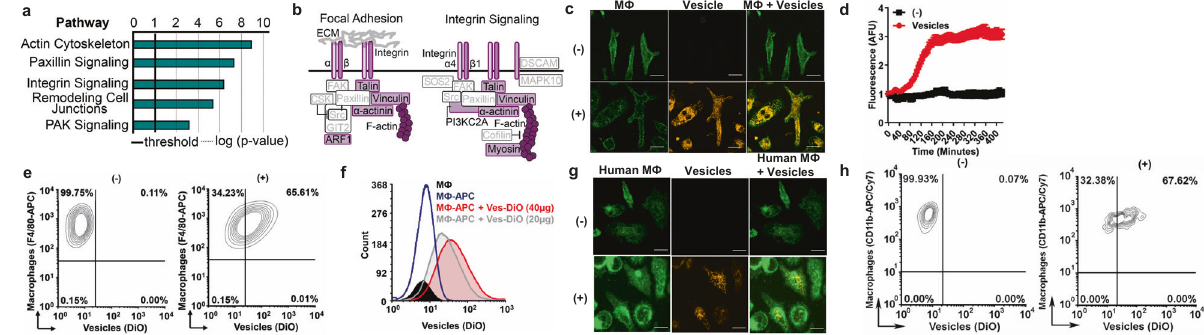
Fig. 2 Tick EVs bind to mammalian immune cells. a Overrepresentation of proteins involved in cell adhesion signaling networks in I. scapularis salivary gland EVs. The biological relationship between proteins was determined using the right-tailed Fisher ’ s exact test with Benjamini – Hochberg multiple-testing correction. p < 0.05; − log ( p value) >1.5. b Graphic representation of focal adhesion and integrin signaling proteins (purple) found in I. scapularis salivary gland EVs. Confocal images of c murine bone marrow-derived macrophages (BMDMs) (bar = 20 µ m) and g macrophages derived from human peripheral blood mononuclear cells (green) bound to I. scapularis EVs labeled with PKH26 (orange) (bar = 20 µ m), respectively. Cells were pre-treated with cytochalasin D (5 µ M). ( − ) No EVs; ( + ) EVs. Images are representative of two independent experiments. d Arbitrary fl uorescent units (AFU) of murine BMDMs bound to PKH26-labeled tick EVs (red). BMDMs incubated in the absence of EVs (black). Each time point represents the mean fl uorescence from seven different cells minus background and normalized to time 0. Graphs show one of two independent experiments. Flow cytometry with e murine BMDMs (F4/80 + -APC) and h human macrophages (CD11b + -APC/Cy7) bound to DiO-labeled tick EVs (40 µ g), respectively. No EVs ( − ); EVs ( + ). Figures are representative of three biological replicates. f Flow cytometry analysis of unlabeled BMDMs (black), F4/80-APC-labeled BMDMs (blue), F4/ 80-APC-labeled BMDMs bound to 40 µ g DiO-labeled tick EVs (red), and F4/80-APC-labeled BMDMs bound to 20 µ g of DiO-labeled and 20 µ g unlabeled tick EVs (gray). The histogram shows one of three biological replicates. PKH26 is a red fl uorescent dye with long aliphatic tails 45 . In c , g , PKH26